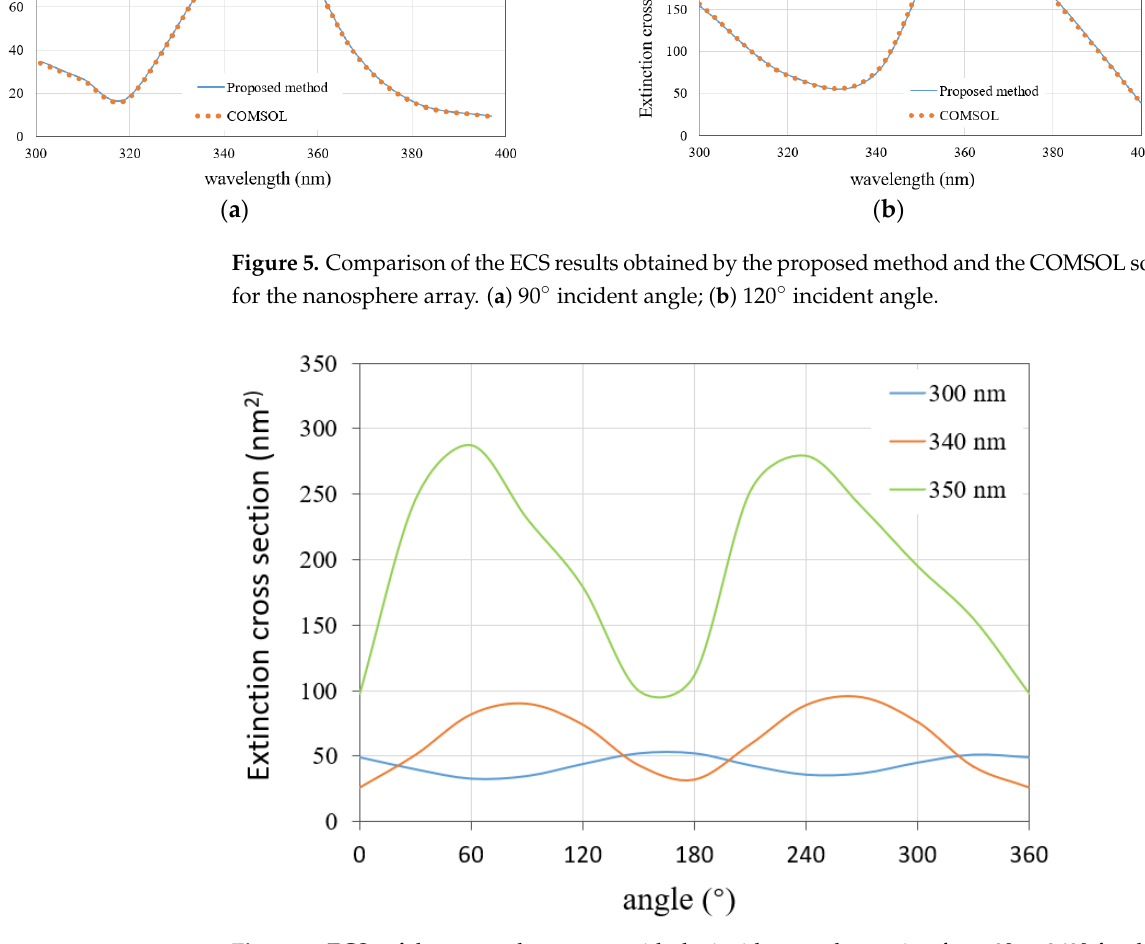
Figure 5. Comparison of the ECS results obtained by the proposed method and the COMSOL soft- ware for the nanosphere array. ( a ) 90° incident angle; ( b ) 120° incident angle.